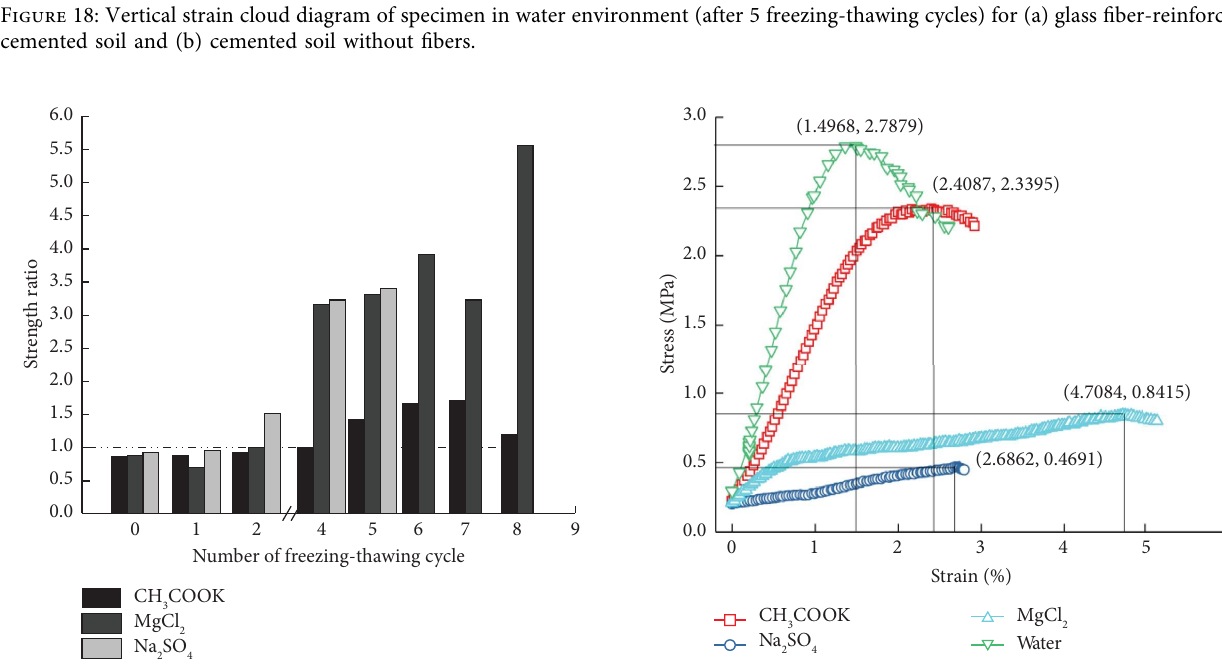
Figure 19: Te relationship between the snow-melting agent in- fuences the strength ratio and the number of freezing-thawing cycles.